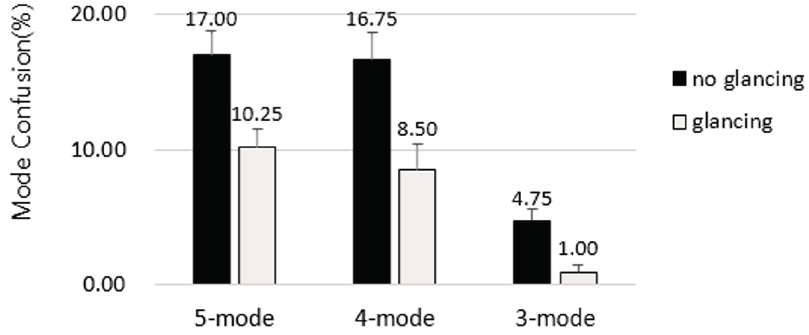
Figure 13. Mode confusion rates with the three investigated ACC interfaces for users glancing and not glancing at the